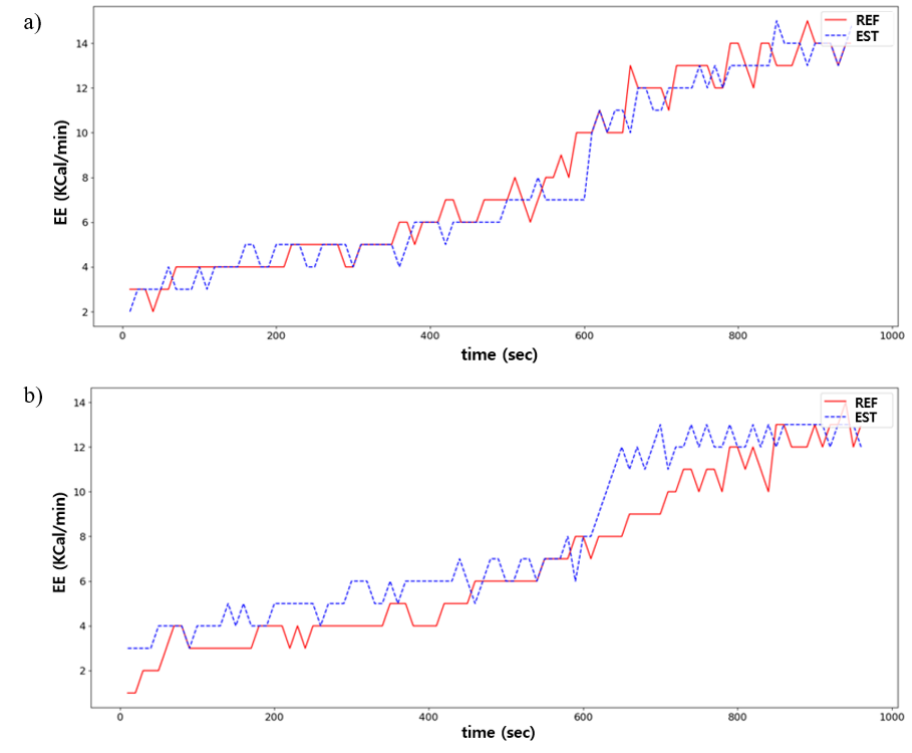
Figure 11. Comparison between the predicted (EST) and ground truths (REF) in EE estimation: ( a ) is the best case; ( b ) is the worst case.